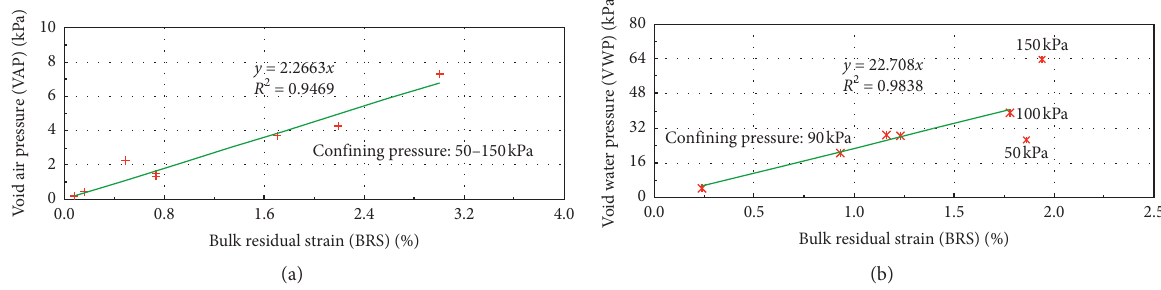
Figure 7: Controlling influence of bulk residual strain on void air/water pressures (based on the maximum values in Table 2). (a) In- dependent of confining pressure (samples 1–3 and 9-10). (b) Dependent of confining pressure (samples 4–8).